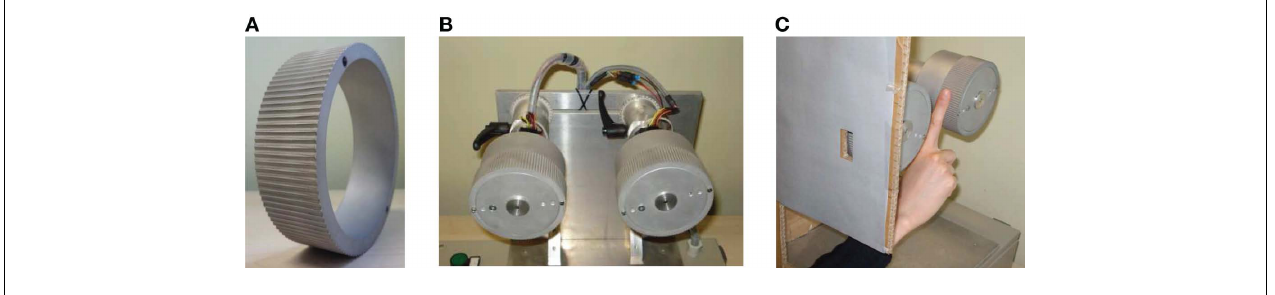
through a small window; in the tactile condition they touched with their right index finger the second wheel occluded to vision by a shield; in the bimodal condition they observed and touched the two wheels